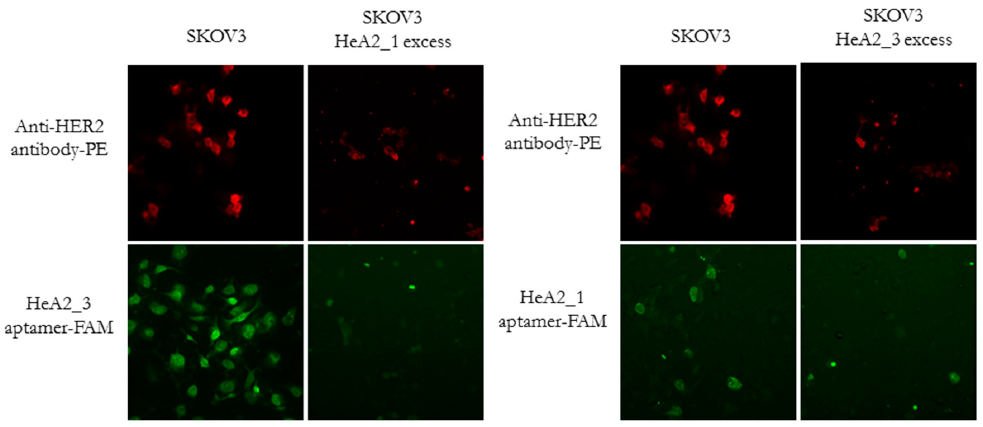
Figure 6. Fluorescence microscopy analysis of the aptamer binding specificity and epitope competition. Cells were stained with the anti-HER2 antibody (red) or aptamers HeA2_1 or HeA2_3 (green) in the absence (( left ) panels) and presence (( right ) panels) of an excess aptamer HeA2_1 or HeA2_3. Images were taken at a magnification of 200×.